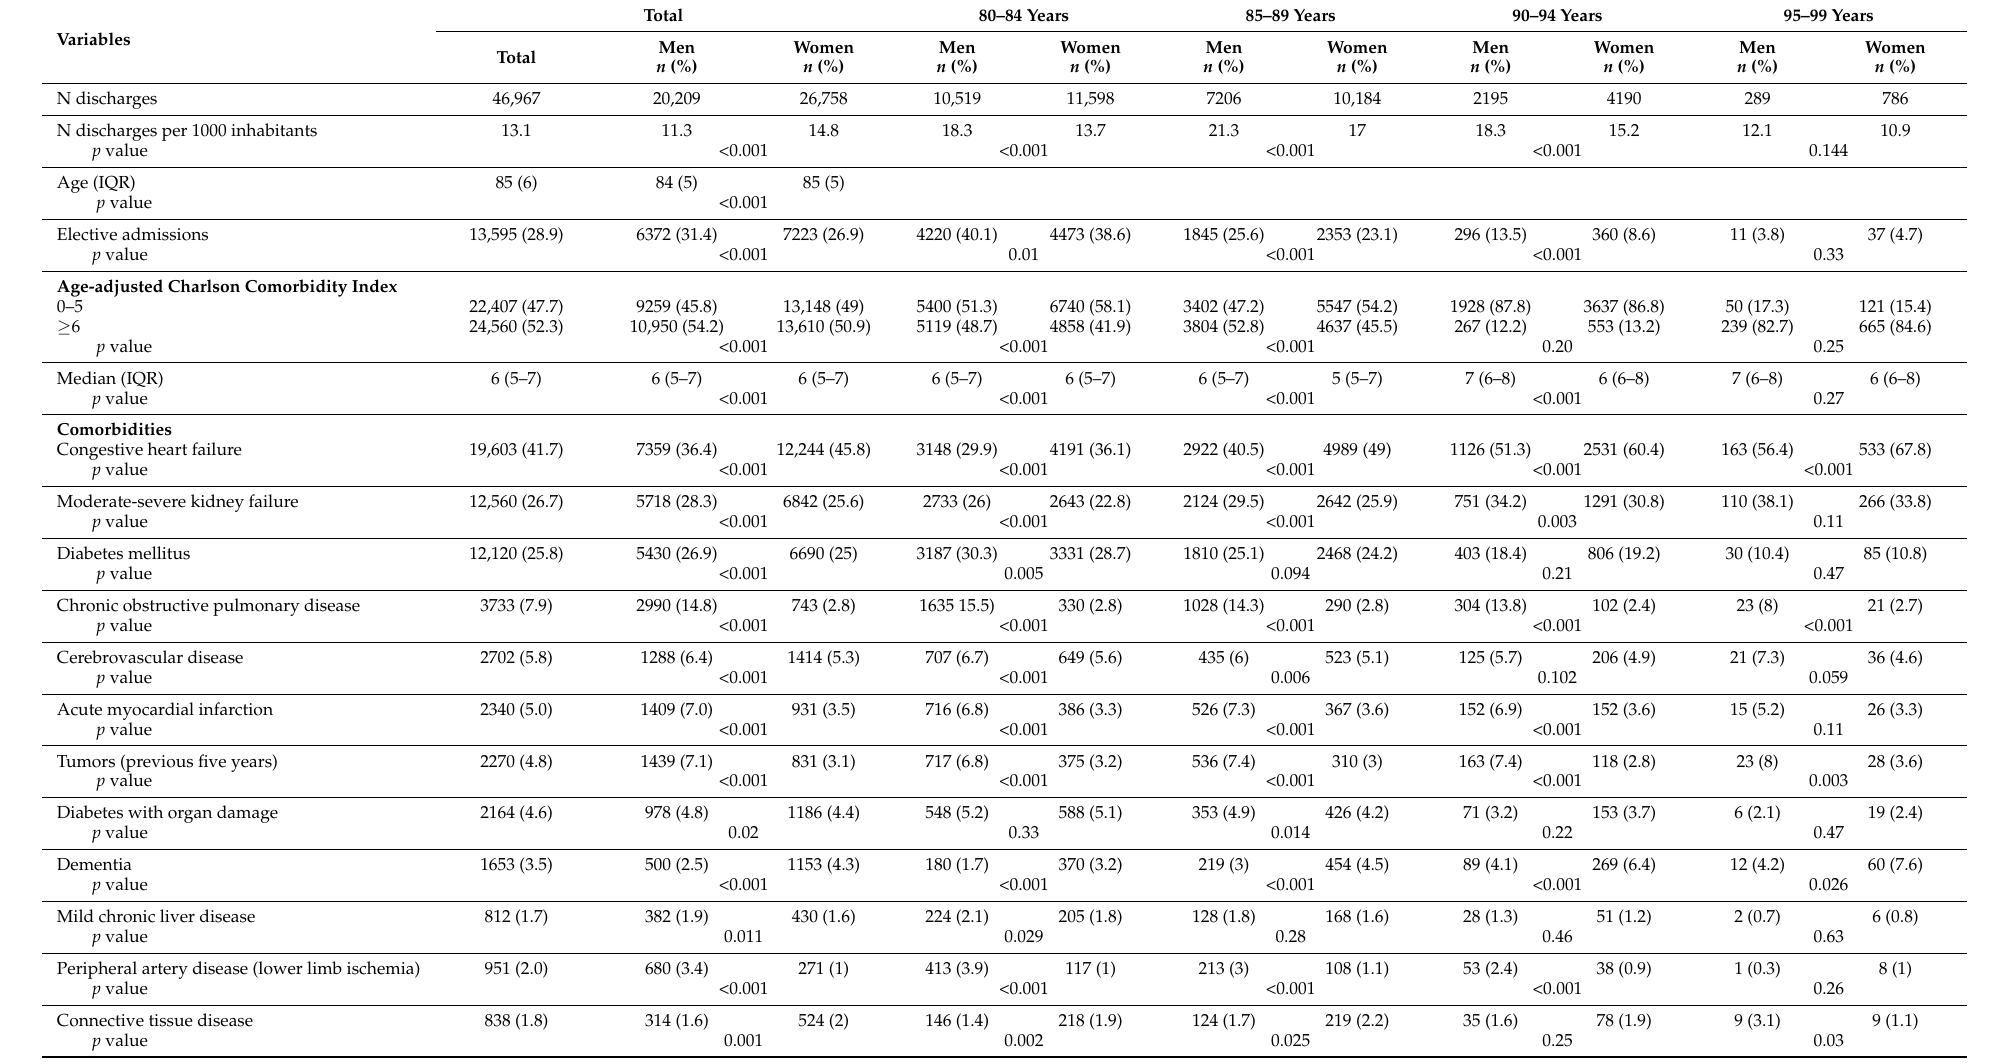
Table 3. Epidemiological characteristics, comorbidities, and outcomes in discharged patients with aortic stenosis by sex and age